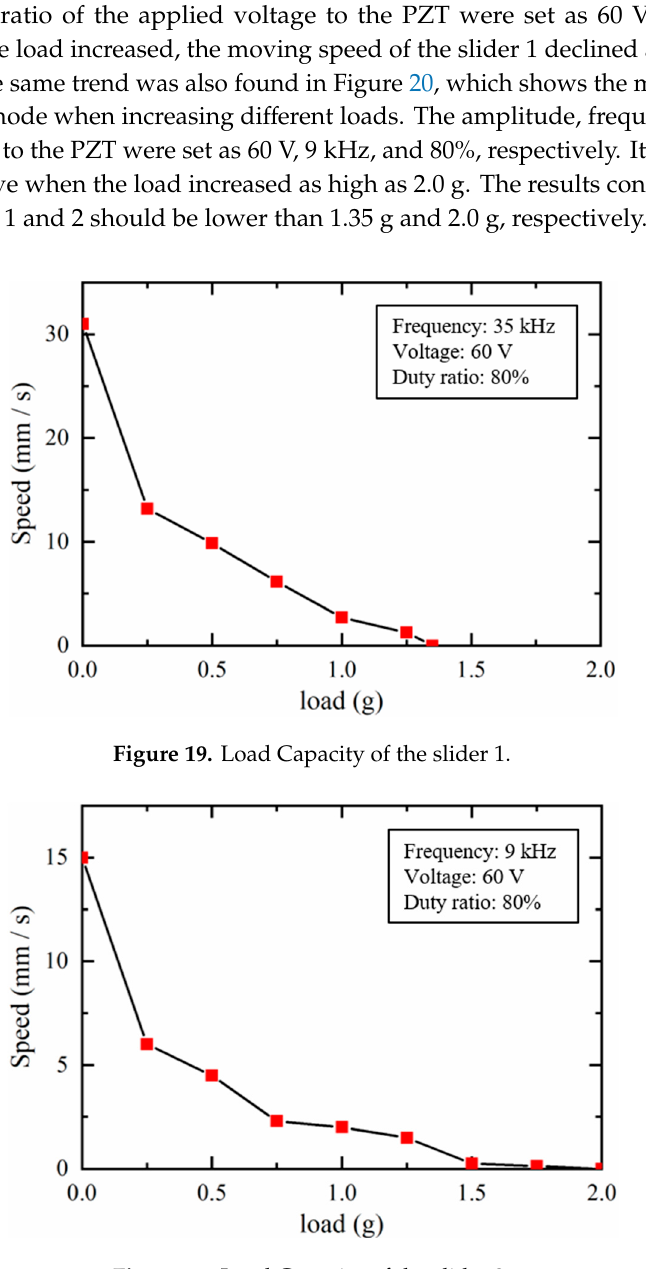
Figure 20. Load Capacity of the slider 2.